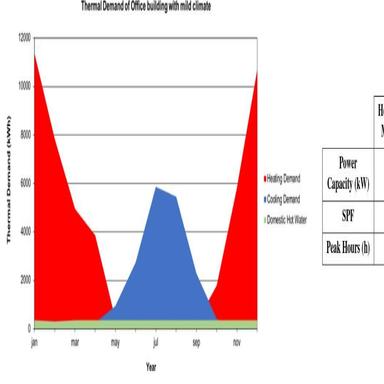
Thermal loads for an office building in a mild climatic region.